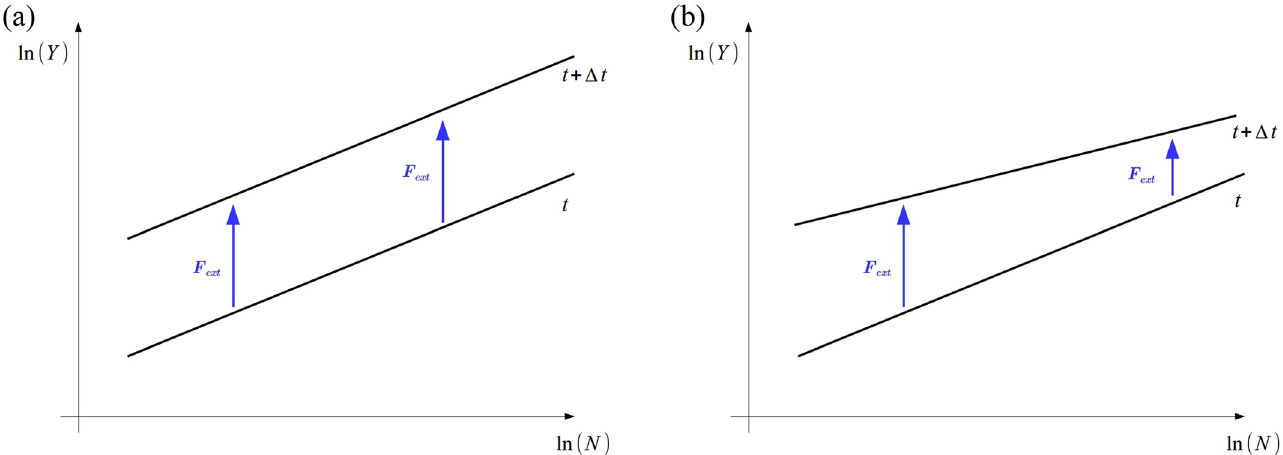
Fig 9. Schematic drawing representing the plane ln Y -x-ln N with two scenarios for the external vectors. Magnitude of the external vector as a function of population size for every single Brazilian municipality in our subset. In the first scenario (on the right), the magnitude of the external vectors is the same regardless of city size; implying that the slope of the fit line (in ln Y -x-ln N plane) remains constant from t to t + Δ t . That is more or less what happens in the GDP of the Brazilian municipalities, revealing that this urban variable is in a mature state in the system. In the second scenario (on the left), the external vector is smaller for bigger cities, which implies that the slope of the fit line decreases with time (from t to Δ t ). That is apparently the case for the water network length of the Brazilian municipalities, suggesting that this urban metric is not mature in the system.